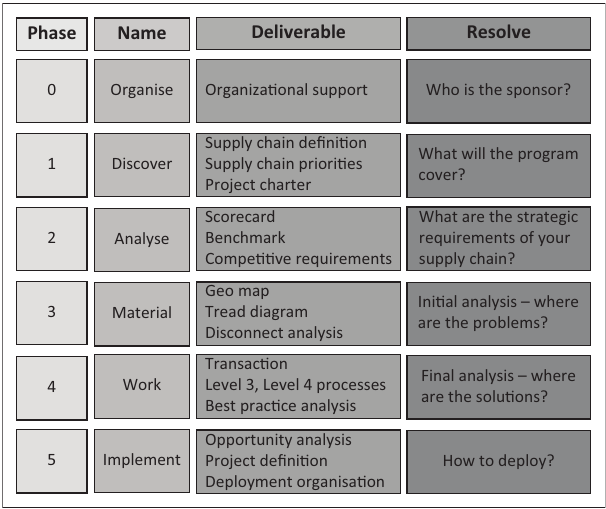
FIGURE 2: Supply Chain Operations Reference framework implementation